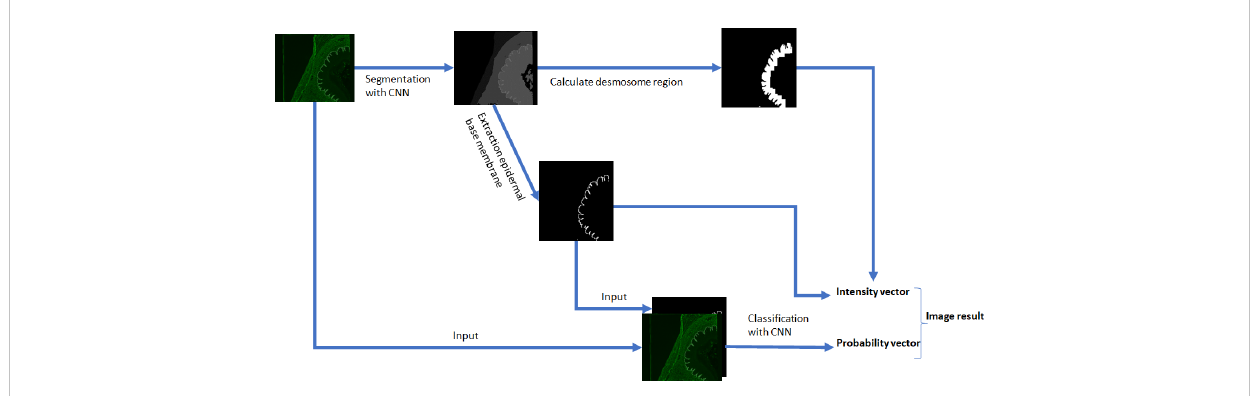
FIGURE 4 Steps for processing esophagus images. The fi rst processing path segments the image with a convolutional neural network (CNN) into six tissue segments plus background and extracts the epidermal basement membrane as input to the classi fi cation path. The segmentation mask is post- processed to calculate the desmosome region. The spatial information is used for intensity estimation of found